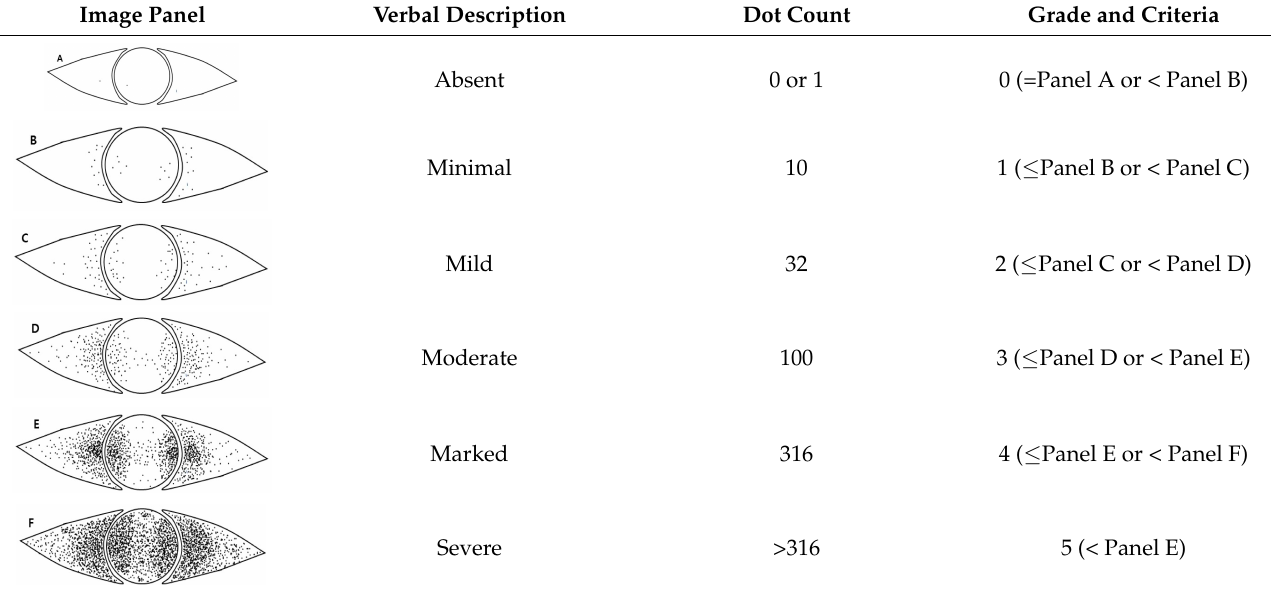
Table 9. Ocular surface scoring methods by the Oxford scoring system (Bron et al. [155]). Image